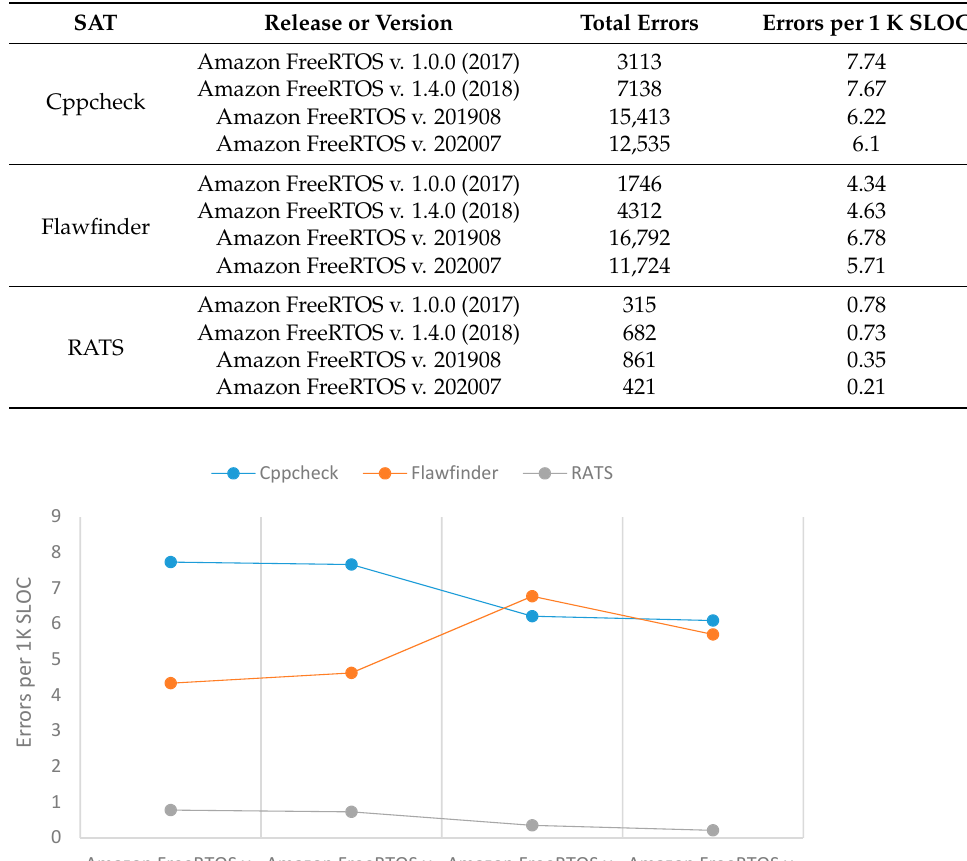
Table 7. Total errors and errors per 1K SLOC of Amazon FreeRTOS.